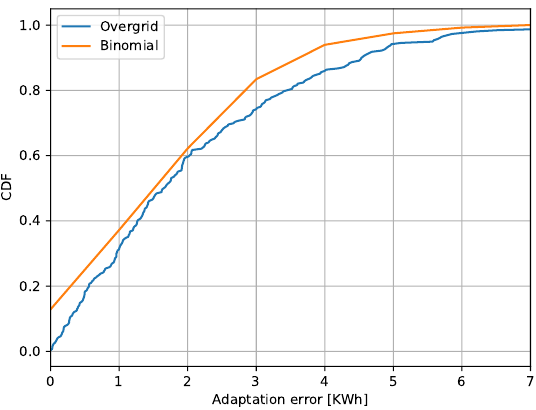
Figure 11. CDF of the DSO adaptation errors caused by quantized loads and comparison with the binomial